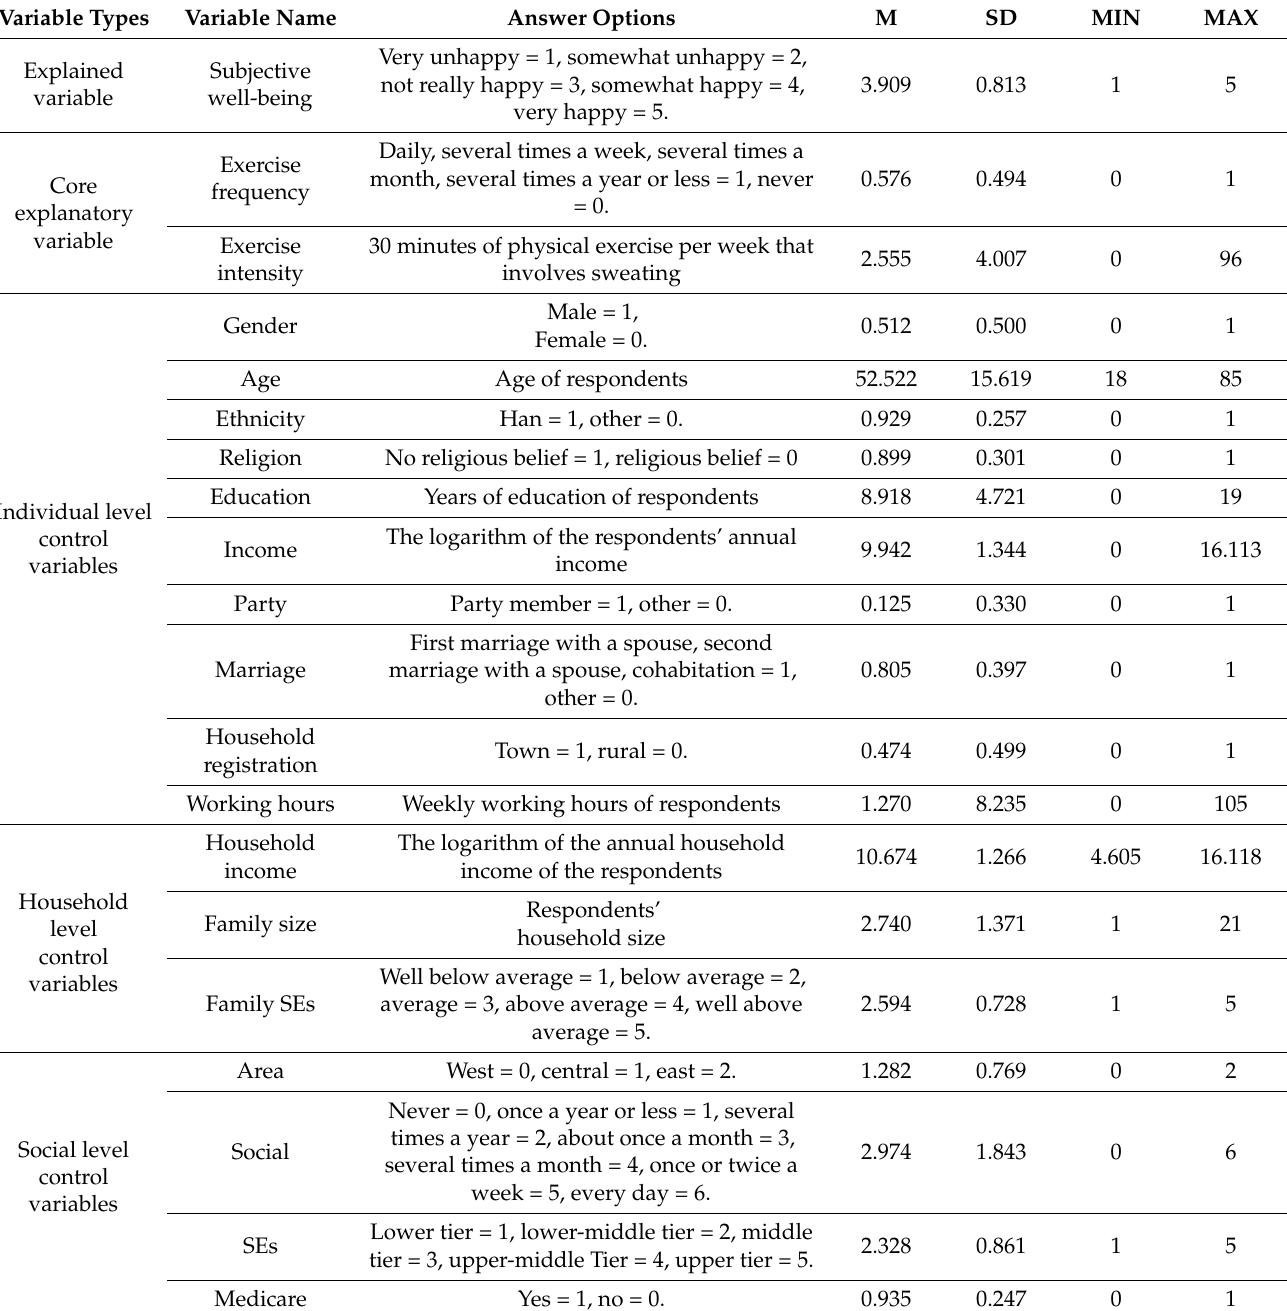
Table 1. Descriptive